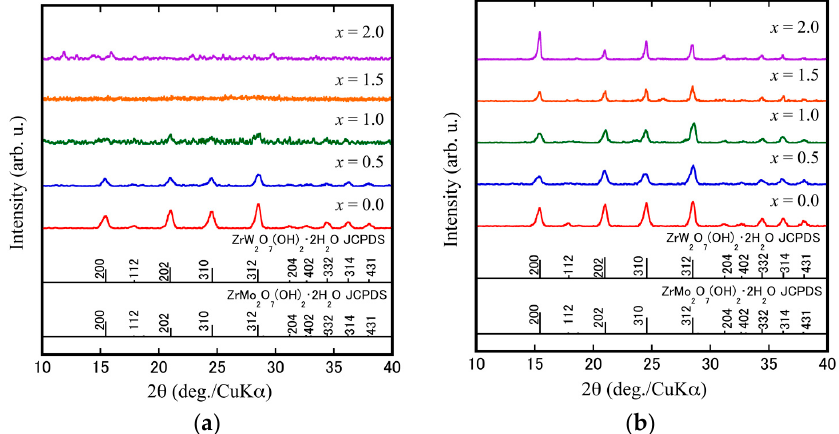
Figure 1. XRD patterns of the ZrW 2 − x Mo x O 7 (OH) 2 ·2H 2 O precursors by ( a ) sol–gel stage; ( b ) sol–gel- hydrothermal stage.